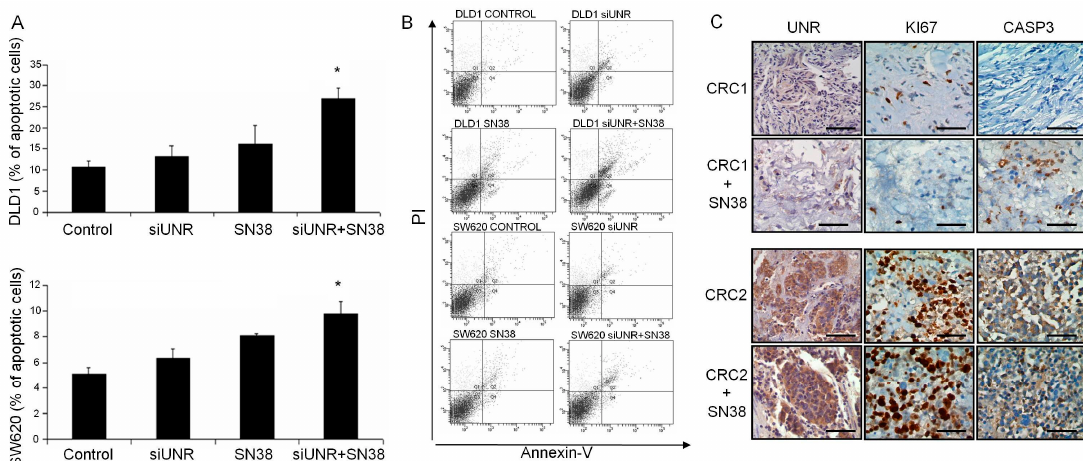
Figure 4. UNR influence camptothecin response in CRC derived cell lines and patients. ( A ) Bar diagram shows the percentage of both early and late apoptotic cells stained positive for Annexin-V after di ff erent treatments. DLD1 and SW620 cell lines were UNR downregulated and / or treated with camptothecin (SN38). Combination of UNR downregulation and camptothecin treatment increased apoptosis compared to individual treatments in DLD1 (up) or SW620 (down). ( B ) Representative dot blots from flow cytometry acquisition after propidium iodide (PI) and Annexin-V stained DLD1 and SW620 cells lines treated as previously. ( C ) Immunohistochemical staining for UNR, Ki67, and cleaved caspase 3 expression in two representative ex vivo assays from colorectal cancer (CRC) fresh tumor samples with the lowest UNR expression (CRC1) and the highest (CRC2) UNR expression levels. Camptothecin treatment did not a ff ect UNR expression, but a reduction in Ki67 and a substantial increase in cleaved caspase 3 expression were observed in CRC1 compared with CRC2. No changes on Ki67 or cleaved caspase 3 were evidenced in CRC2. (* p ≤ 0.05). Scale bars represent 100 µ m .